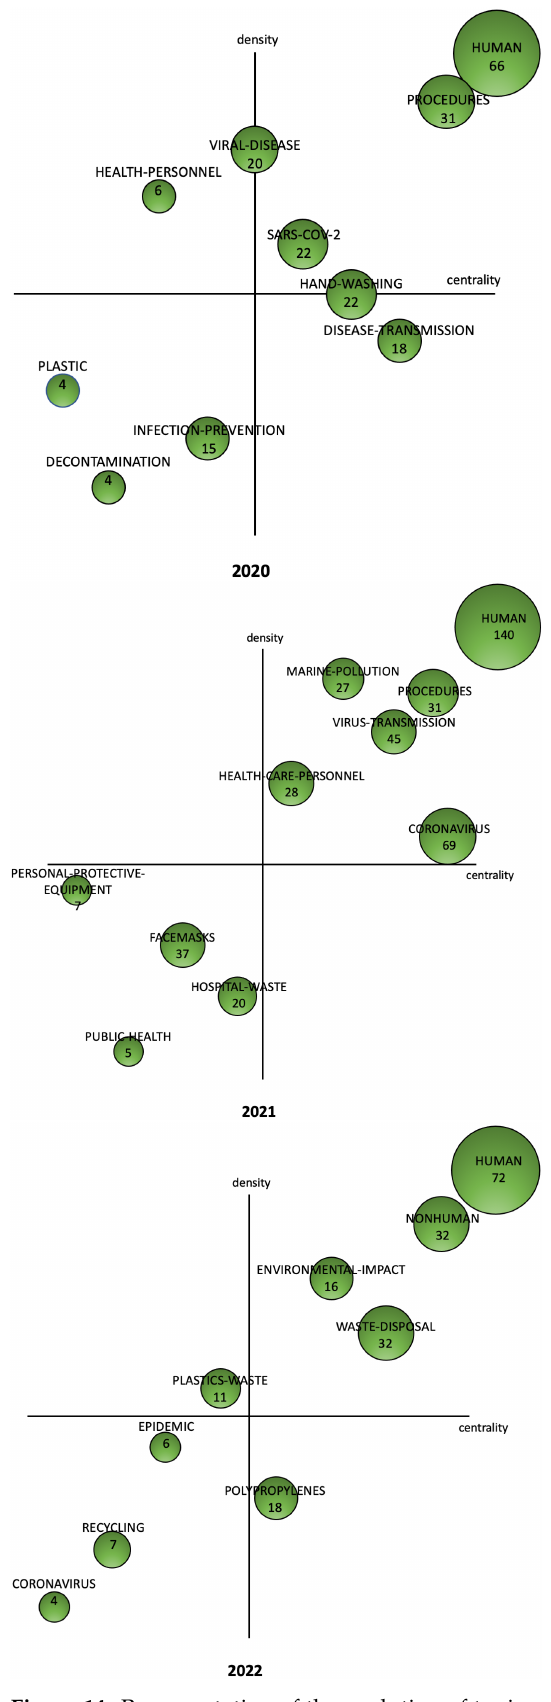
Figure 14. Representation of the evolution of topics over time in the research field using strategy diagrams in terms of the number of documents